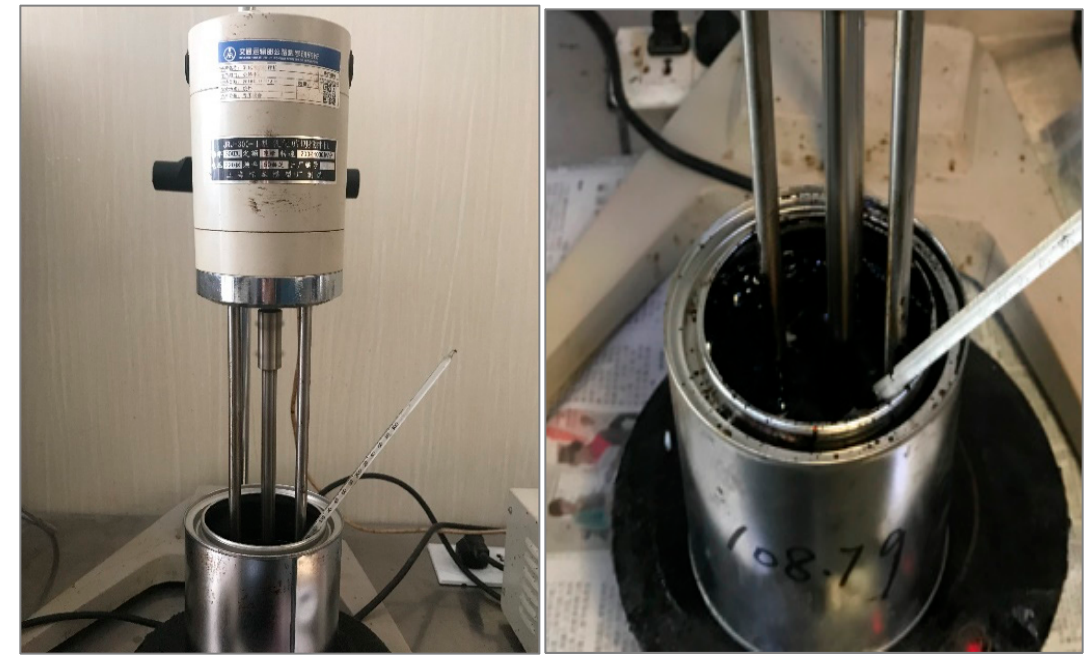
Figure 1. Preparation of HVMA using high-speed shear mixer .